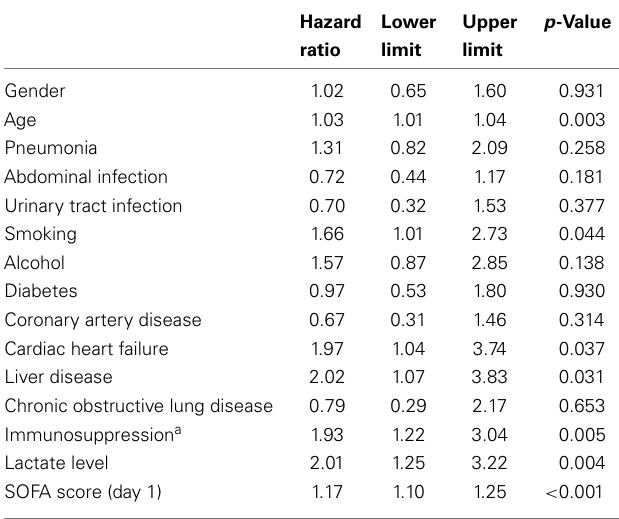
*Patients from the current study and the two pooled comparative cohorts of severe sepsis and septic chock. a According to APACHE II criteria.